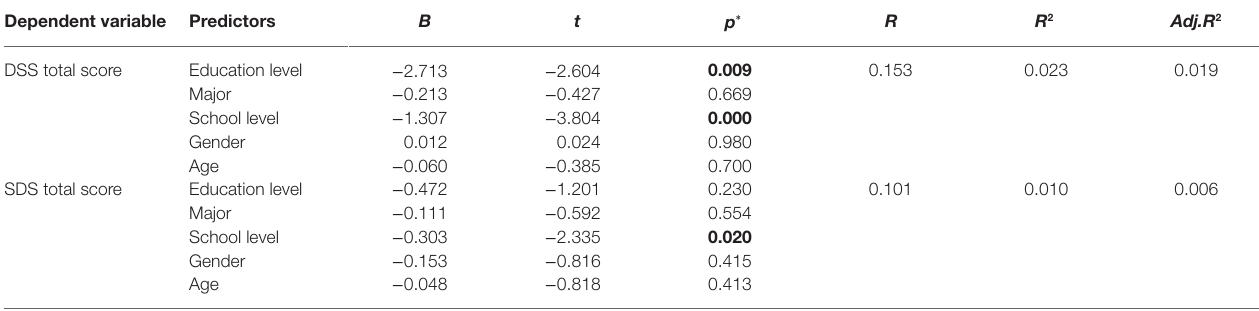
TABLE 4 | Predictors for stigma and social distance by multiple linear regression analysis. Dependent variable Predictors